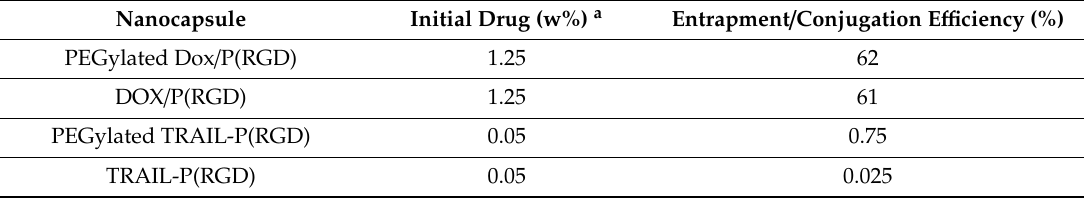
Table 2. Characteristics of TRAIL-P(RGD) NCs and the Dox/P(RGD) NCs. Nanocapsule